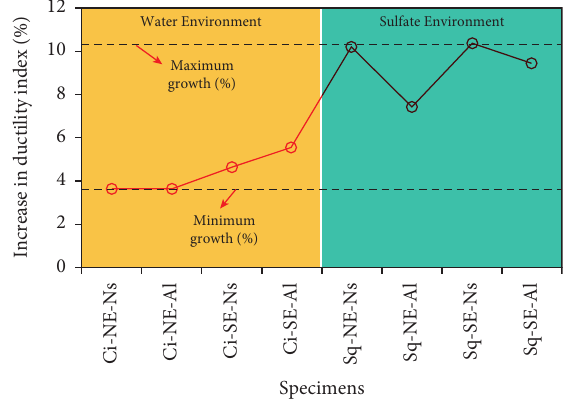
Figure 12: Te increase in the ductility index of circular and square columns retroftted with the proposed jacket compared to the control